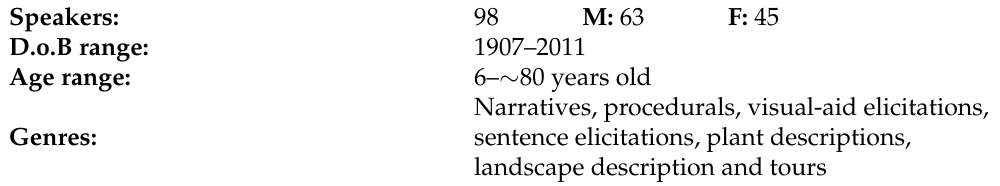
Table A2. Corpus metadata